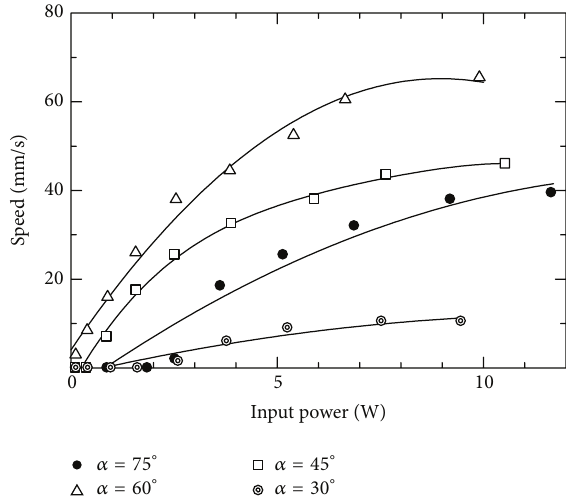
Figure 4: Relationship between input power and speed when the attractive force was set to 8.43 N.